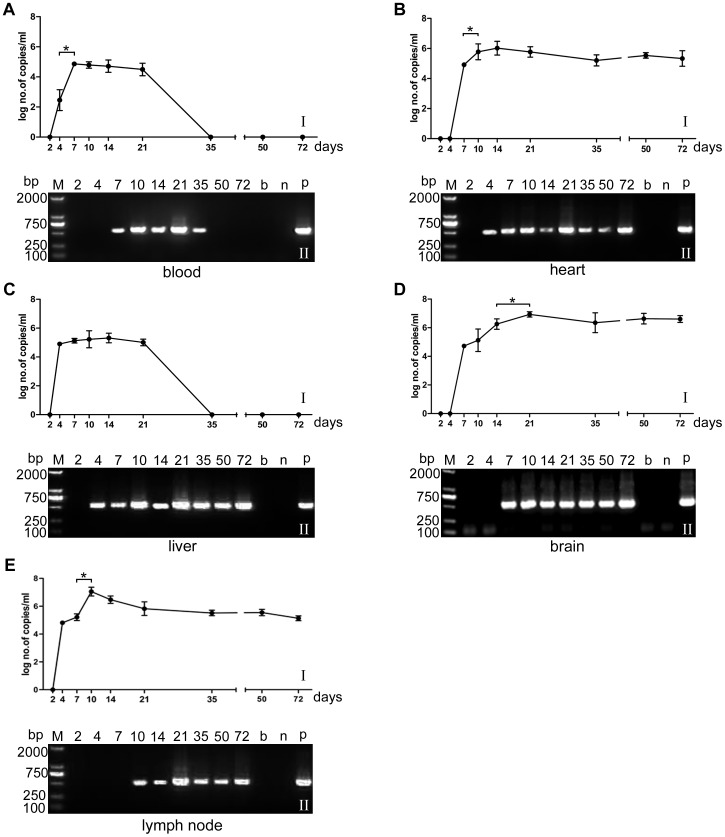
The kinetics of infection in mice with TgCtwh6 isolates.Kinetics of infection in blood and organs after oral infection with 50 cysts of TgCtwh6 isolate (genotype Chinese 1) in mice. I: the number of DNA copies in blood and tissues of the TgCtwh6 isolate post infection at various intervals by qPCR. Each point represents the mean value of the T. gondii DNA copies for five mice ± SD. II: detection of PCR products of T. gondii 529 bp fragments extracted from brain or ascitic fluid in the recipient mice. Abbreviations: A; blood, B; heart, C; liver, D; brain, and E; lymph node. b, n, and p represent blank, negative and positive control. *P<0.05.